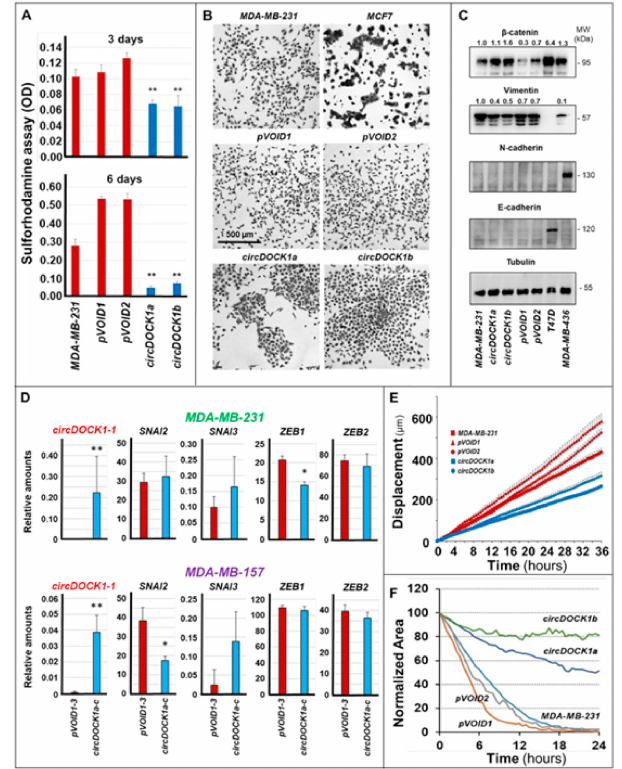
Figure 7. Effects of circDOCK1-1 overexpression on cell proliferation, morphology, EMT, random motility, and